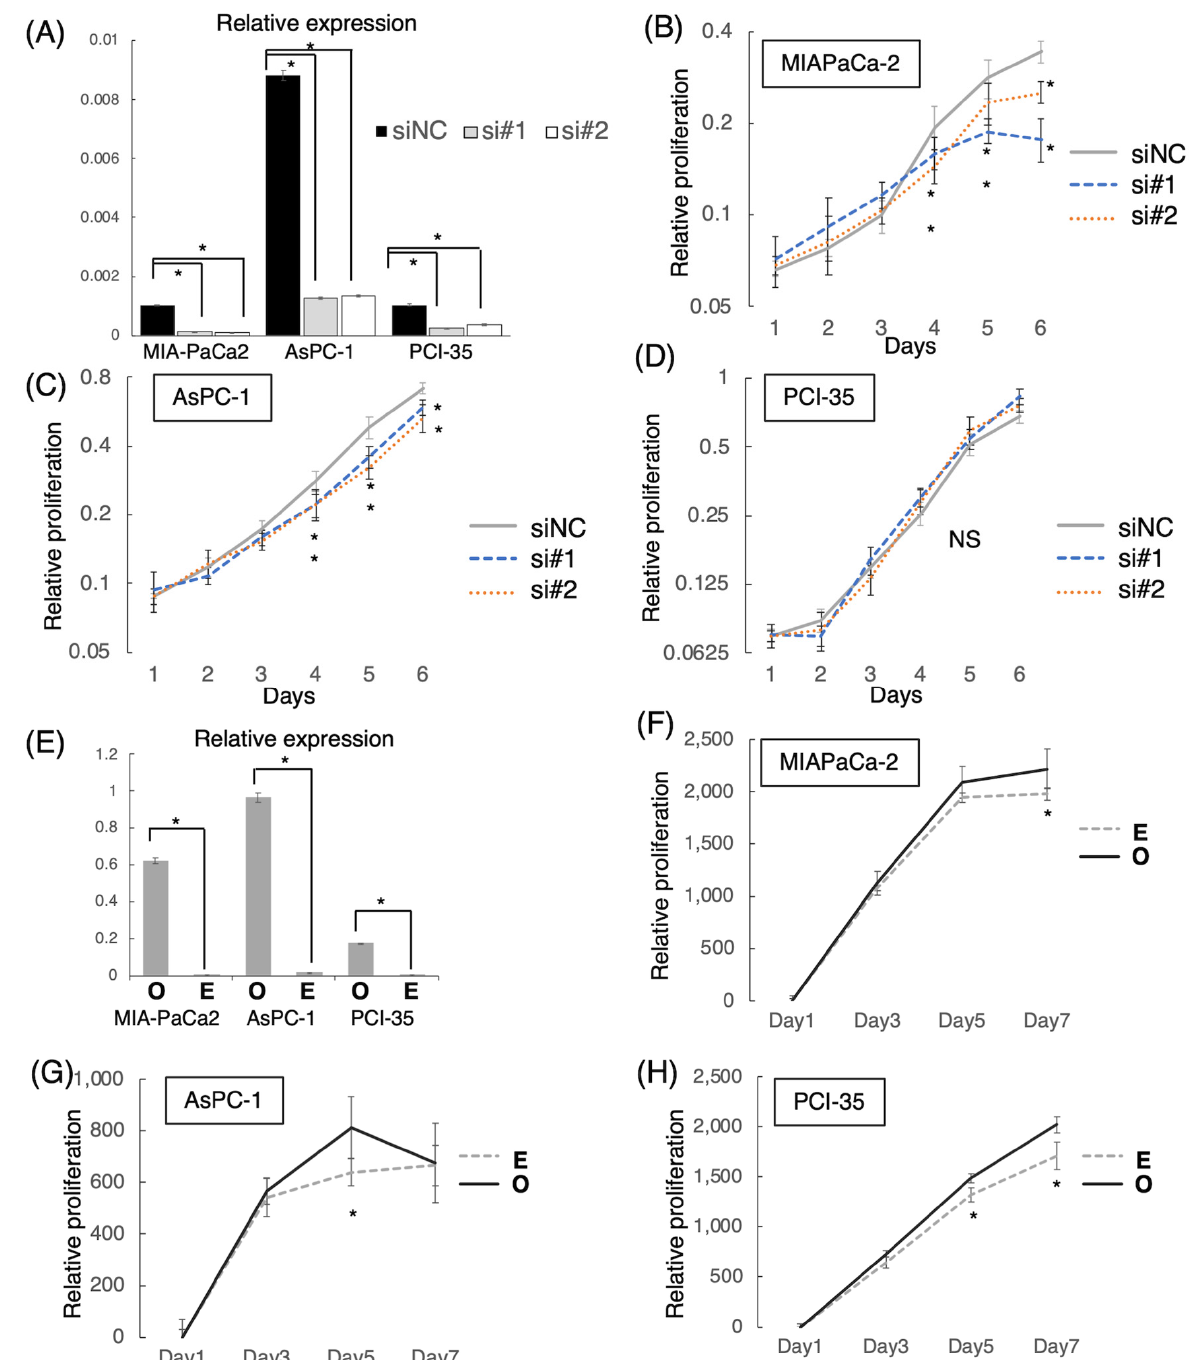
Figure 3. MTT proliferation assays with the knockdown or overexpression of LINC00941 . ( A ) qRT- PCR validation of downregulation of LINC00941 expression by siRNAs. NC, negative control. ( B – D ) The knockdown of LINC00941 suppressed cell proliferation of MIAPaCa-2 and AsPC-1 (* p < 0.05), and did not suppress PCI-35. ( E ) qRT-PCR validation of the overexpression of LINC00941 by cDNA vector transfection. Abbreviations: E, empty vector; O, overexpression. ( F – H ) The